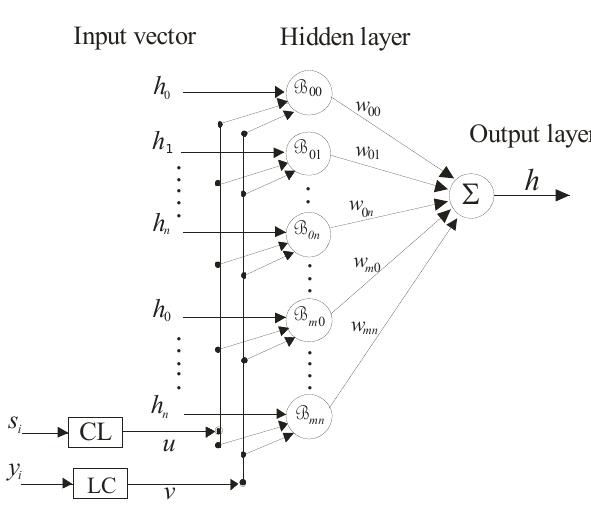
Figure 8. Structure of the Bezier